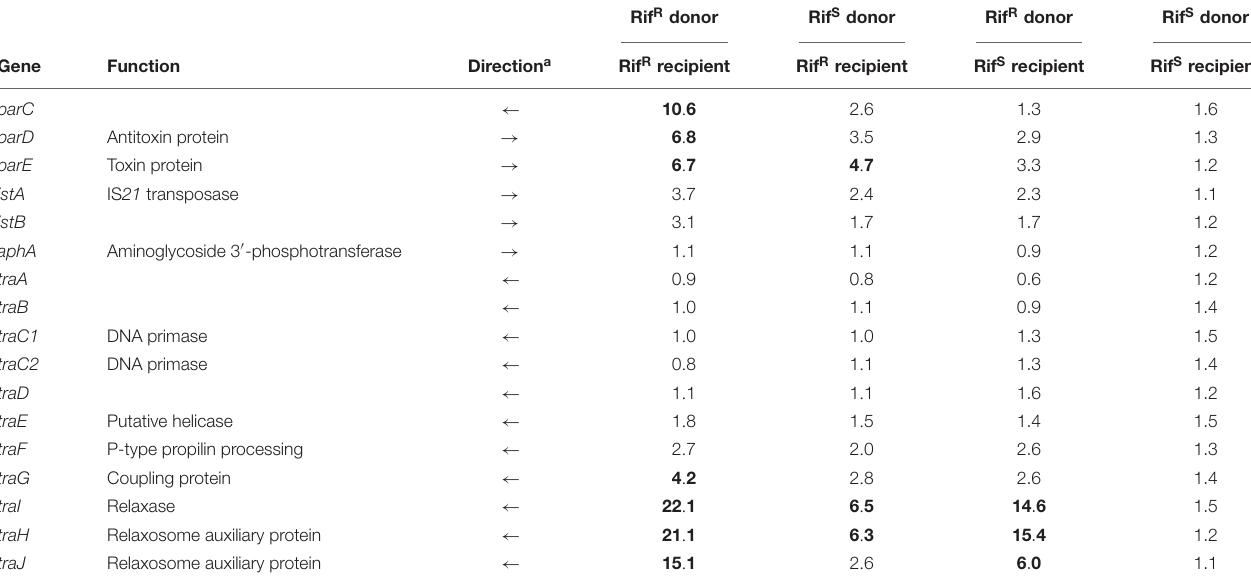
The RP4 gene name and direction of transcription relative to the direction of transfer are indicated on the left columns. Combinations of donor and recipient strains are indicated in the upper rows. a The direction of transcription corresponds to that shown in Figure 2 . ← , mRNA is transcribed from the transfer strand as template; → , mRNA is transcribed from the complementary strand as template. Fold changes > 4.0 are shown in bold.